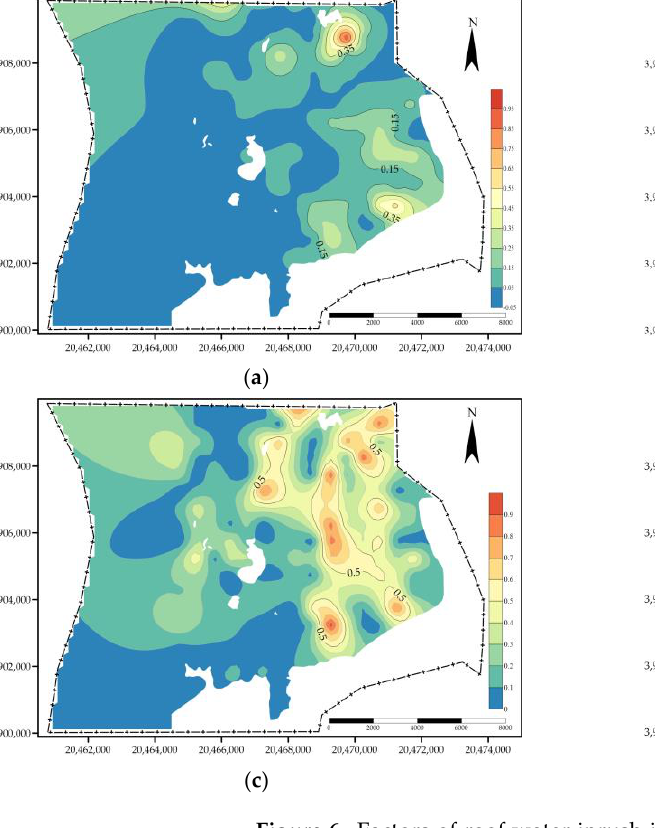
Figure 6. Factors of roof water inrush in geological structure: ( a ) fault density (Fd); ( b ) fault fre- quency density (Ff); ( c ) fault size index (Fs); ( d ) coefficient of variation in inclination angle of coal floor (CDVAC).